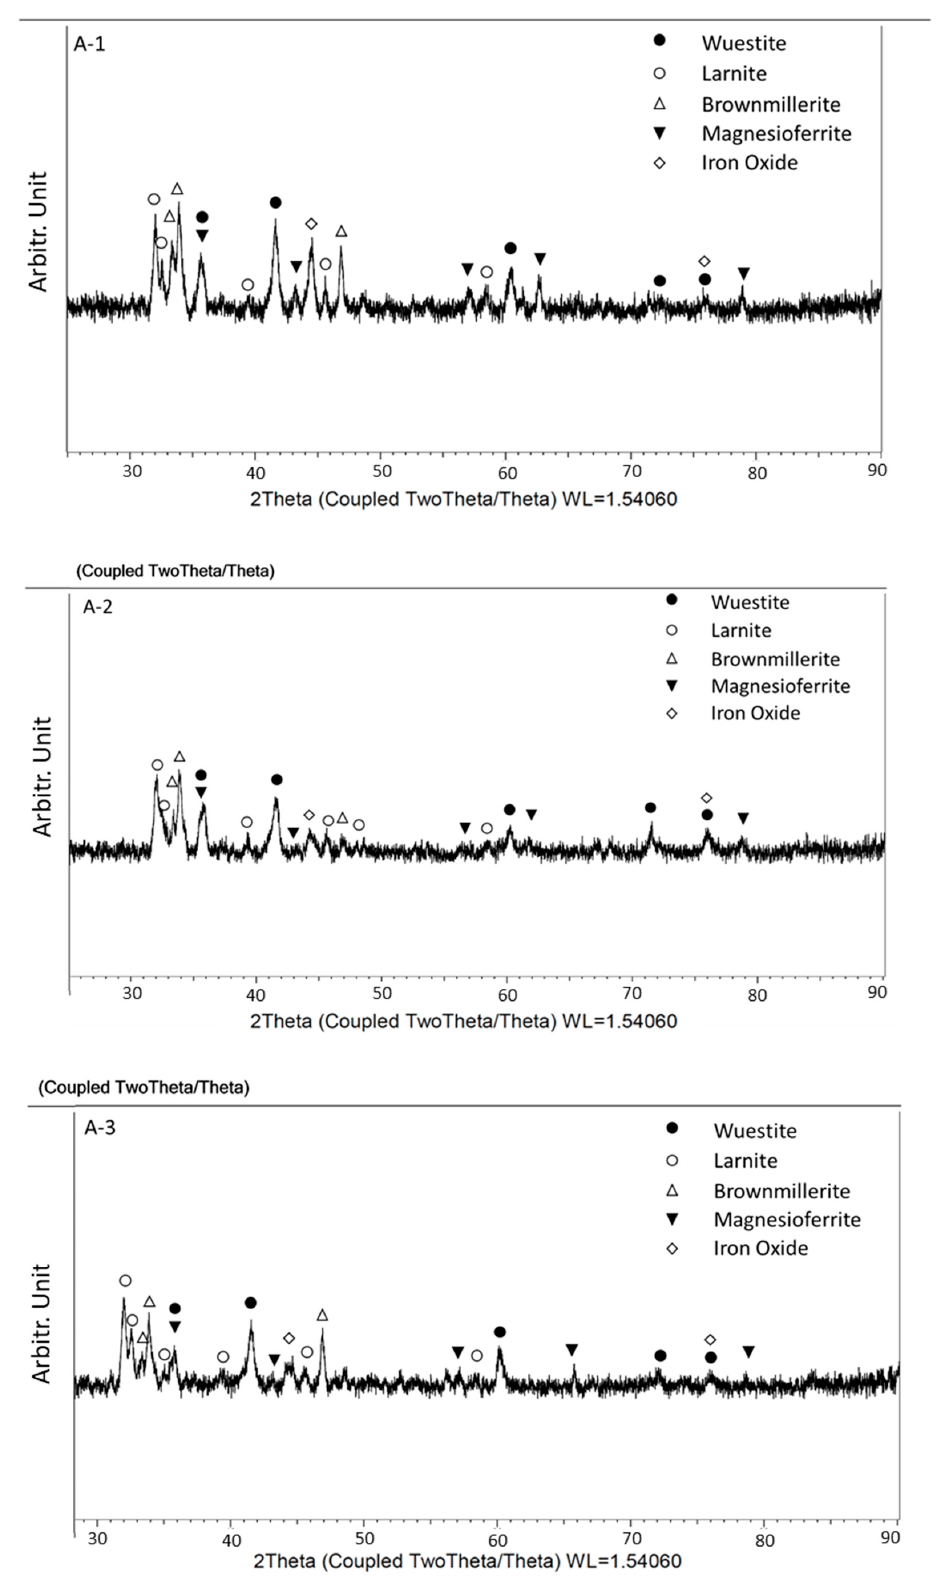
Figure 2. XRD patterns of three different (300x300 µm 2 ) areas of sample A and the main crystalline identified phases.